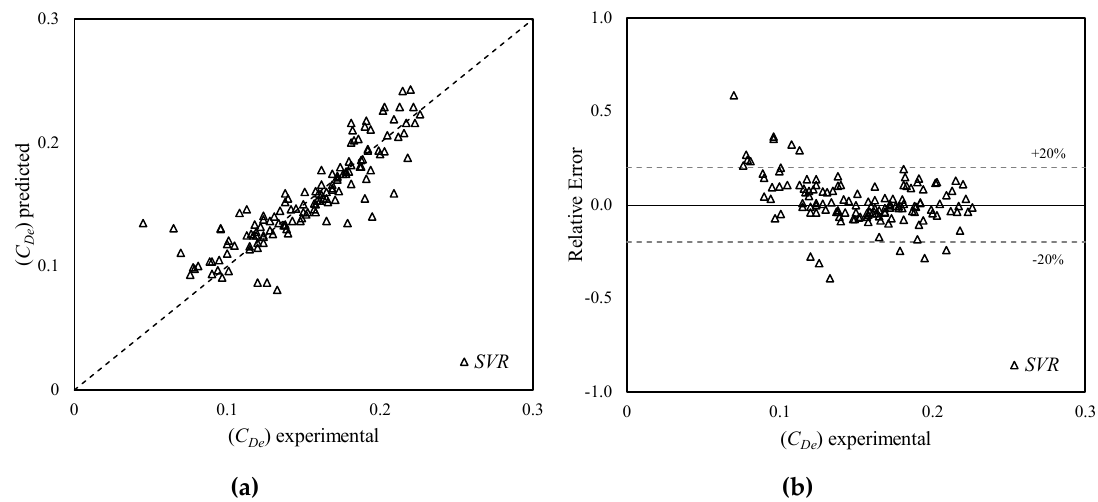
Figure 7. Model 1, SVR algorithm, ( a ) predicted versus experimental results, and ( b ) relative error versus experimental results.